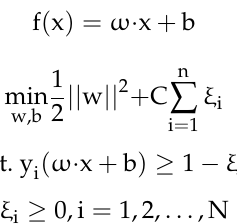
Algorithm 1: K-means SMOTE algorithm used in this